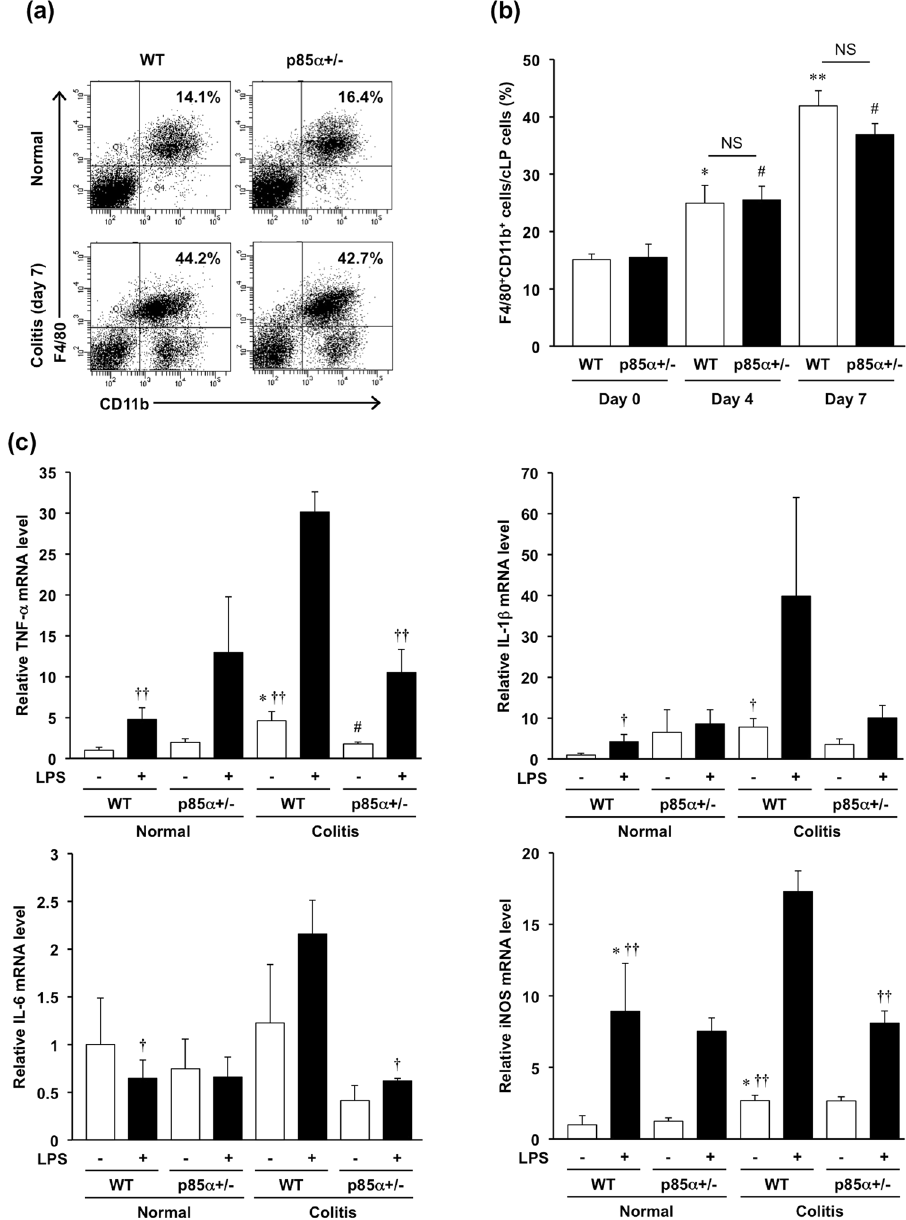
Figure 2. Intestinal macrophages in p85 α+ / − colitis mice express low levels of proinflammatory mediators. Colitis was induced in WT or p85 α+ / − mice through daily treatment with a 3% DSS solution in drinking water for 7 days. cLP cells were isolated from the colons in WT or p85 α+ / − mice at day 0 (normal), day 4 or day 7 after the start of DSS treatment. ( a ) Representative flow cytometry plots show the proportion of F4/80 + CD11b + intestinal macrophages in cLP cells. Plots are representative of the results from 4 independent experiments. ( b ) Quantification of the percentage of F4/80 + CD11b + macrophages in cLP cells was performed using flow cytometry analysis. * p < 0.05; ** p < 0.01, compared with WT normal (Day 0) mice. # p < 0.05, compared with p85 α+ / − normal (Day 0) mice. ( c ) Proinflammatory mediator mRNA expression in F4/80 + macrophages purified from the cLP cells of WT or p85 α+ / − mice at day 0 (normal) or day 7 using the IMag system. F4/80 + macrophages were stimulated with LPS (100 ng/ml) for 4 h. The data are presented as the mean ± SE of 4 independent experiments. * p < 0.05, compared with WT normal LPS ( − ). † p < 0.05; †† p < 0.01, compared with WT colitis LPS ( + ). # p < 0.05, compared with WT colitis LPS ( −